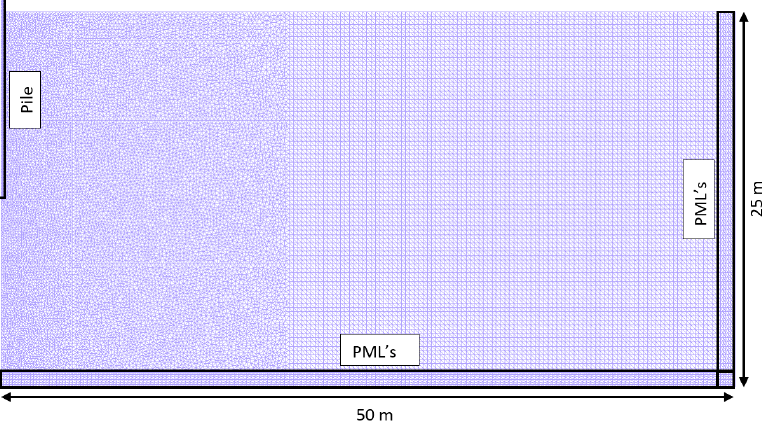
Figure 10. FE–PML mesh adapted to model the pile–ground system.